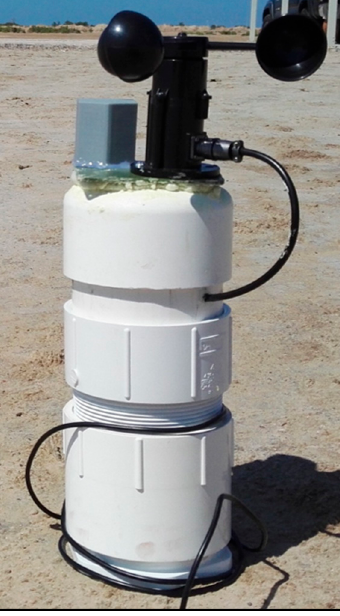
Figure 10. Upper part of the buoy where the electronics are housed and the external sensors are fixed.